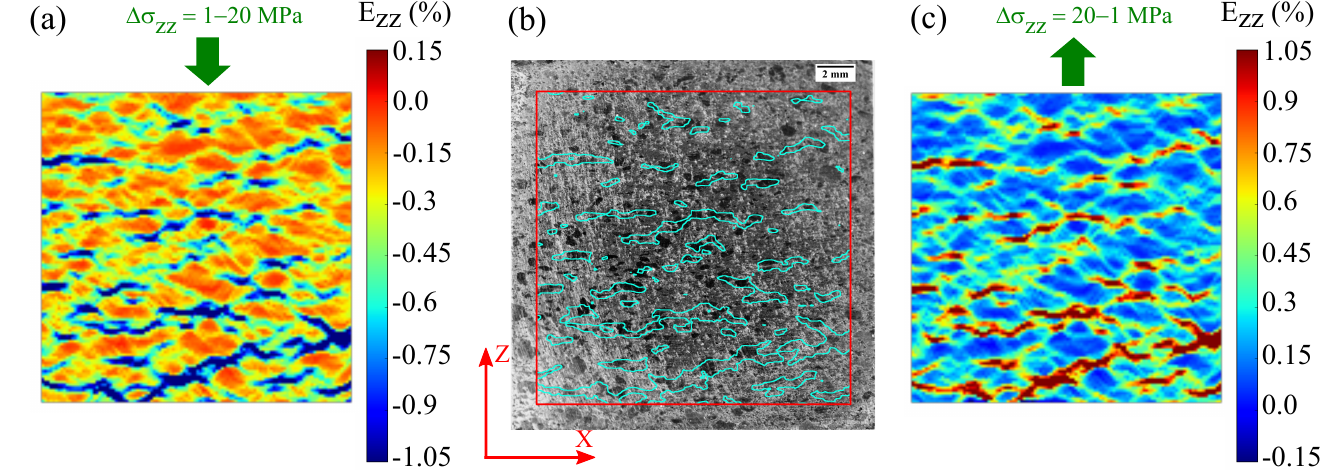
Figure 5. ( a ) E zz strain field of RM, obtained using DIC, of the elastic part of the loading between 1 and 20 MPa. ( b ) Image recorded with a XIMEA camera, prior to the deposition of the speckle pattern (20 × 20 × 20 mm 3 ). Only the G2 particles (in darker grey values) can be distinguished in this image. The square in red indicates the region of interest (ROI) where DIC is performed. The cyan outlines, which are obtained from Figure 5a, show the outline of the regions where strain values correspond to − 0.6% ( c ) E zz strain field of the elastic part of the unloading between 1 and 20 MPa.